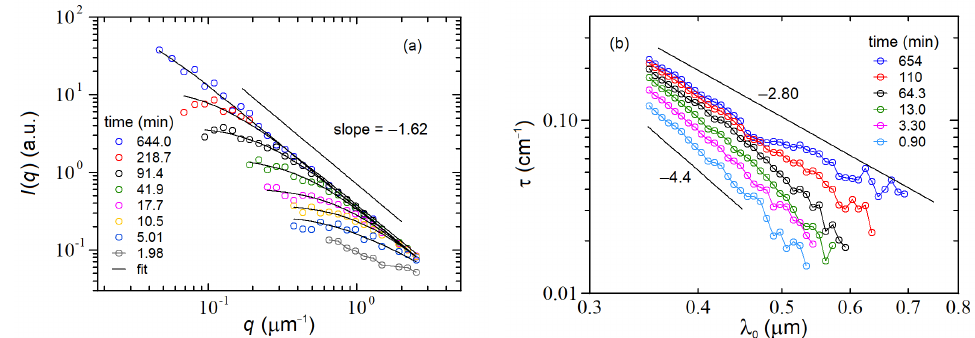
Figure 4. Colloidal aggregation of latex spheres characterized by the LA-SLS+MWT instrument. ( a ) Scattered intensity I ( q ) data (symbols) and fits (continuous lines) as a function of q for different times after addition of salt to the colloidal suspension; ( b ) behavior of the turbidity as a function of wavelength at different times for the same sample of panel ( a ).